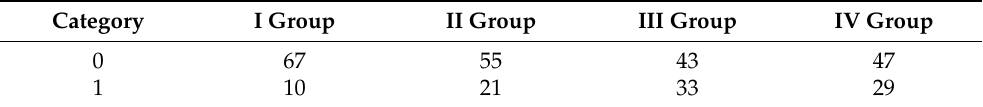
Table 9. Number of observations by category of the dependent variable and group based on quartiles of revenue volumes in 2017.